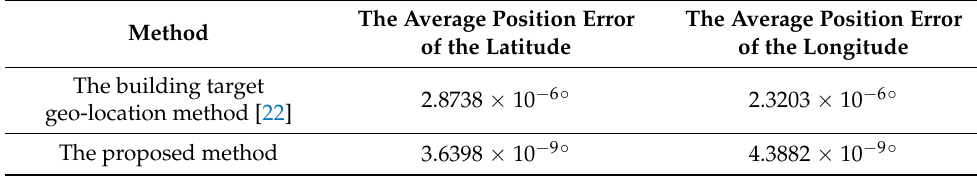
Figure 13. Schematic diagram of the distribution of geo-location results: ( a ) the building target geo-location method in [22]; ( b ) the proposed method. Table 5. Geo-location error results.